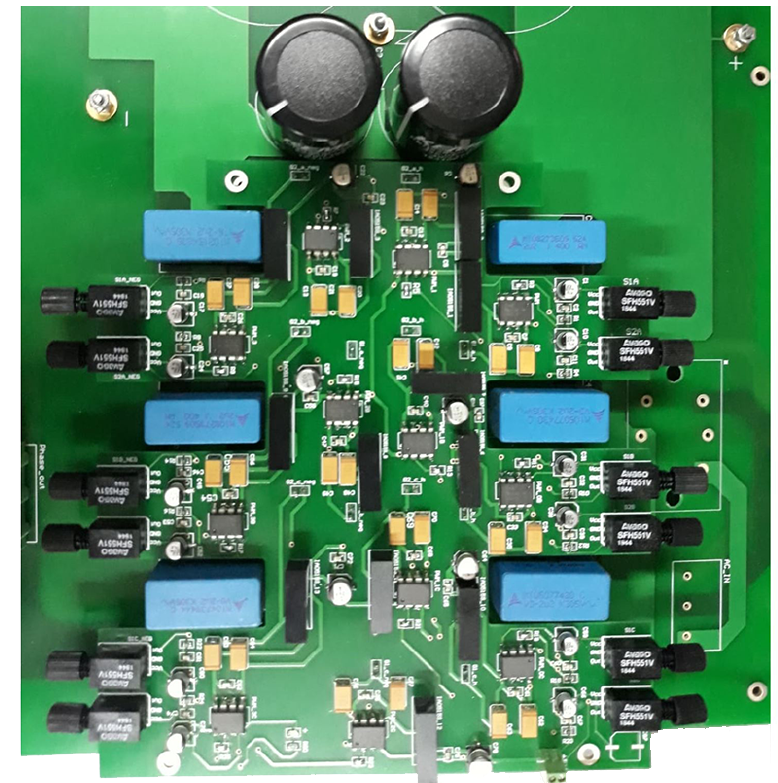
Figure 11. Picture of the three-level NPC inverter prototype.